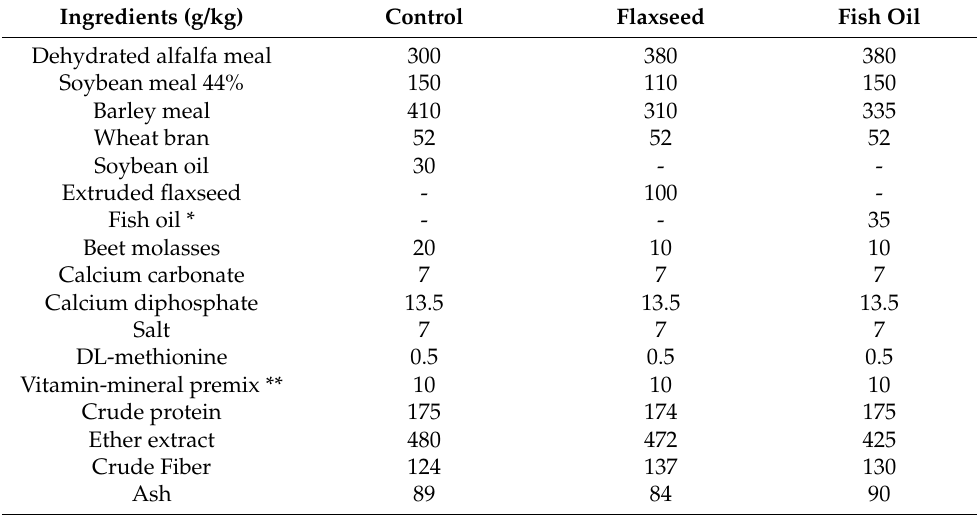
Table 3. Formulation and chemical composition (on fresh matter) of control and n-3-enriched